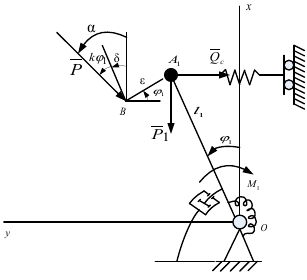
Fig. 1. The computational model of a single inverted pendulum This mathematical model of the inverted single pendulum is general- ized, since in equation (1) the angular eccentricity δ and the linear eccen- tricity ε and in addition, the influ- ence factors i ij q ,(cid:4)(cid:4)q ( ) = i,(cid:4)j 1,2 allow to consider all possible types of elastic elements (soft, rigid,